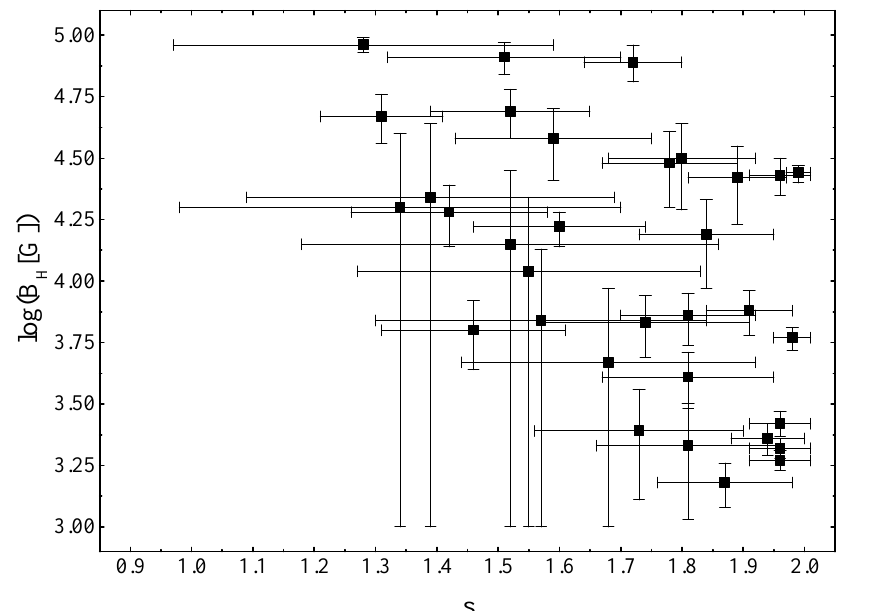
Figure 7. The obtained values of the magnetic field intensity B H and the exponent of the power-law dependence s .